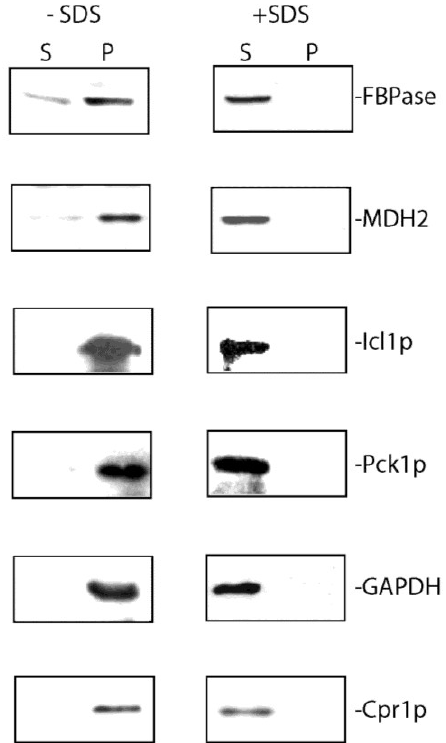
Figure 3. FBPase, MDH2, Icl1p, Pck1p, GAPDH, and Cpr1p are associated with